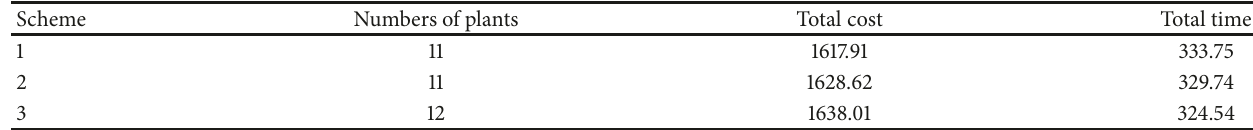
Table 8: Approximate to the target value of the Pareto optimal solution.